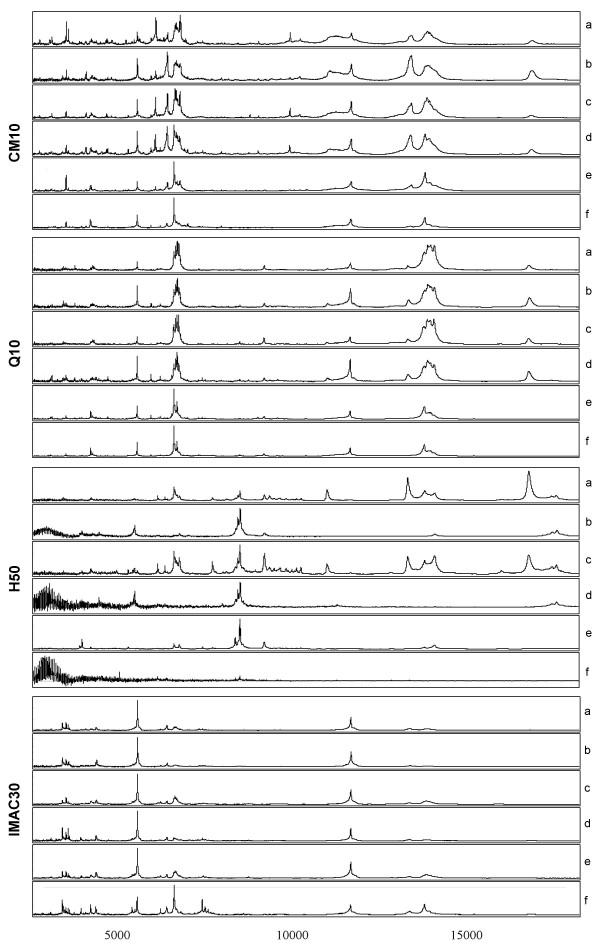
Representative SELDI-TOF MS spectra of pooled CSF sample obtained from all tested conditions using CHCA as matrix. CSF was processed on CM10, Q10, H50 and IMAC30 ProteinChip arrays prepared under the same conditions as described in figure 1, but with CHCA as the energy absorbing matrix.